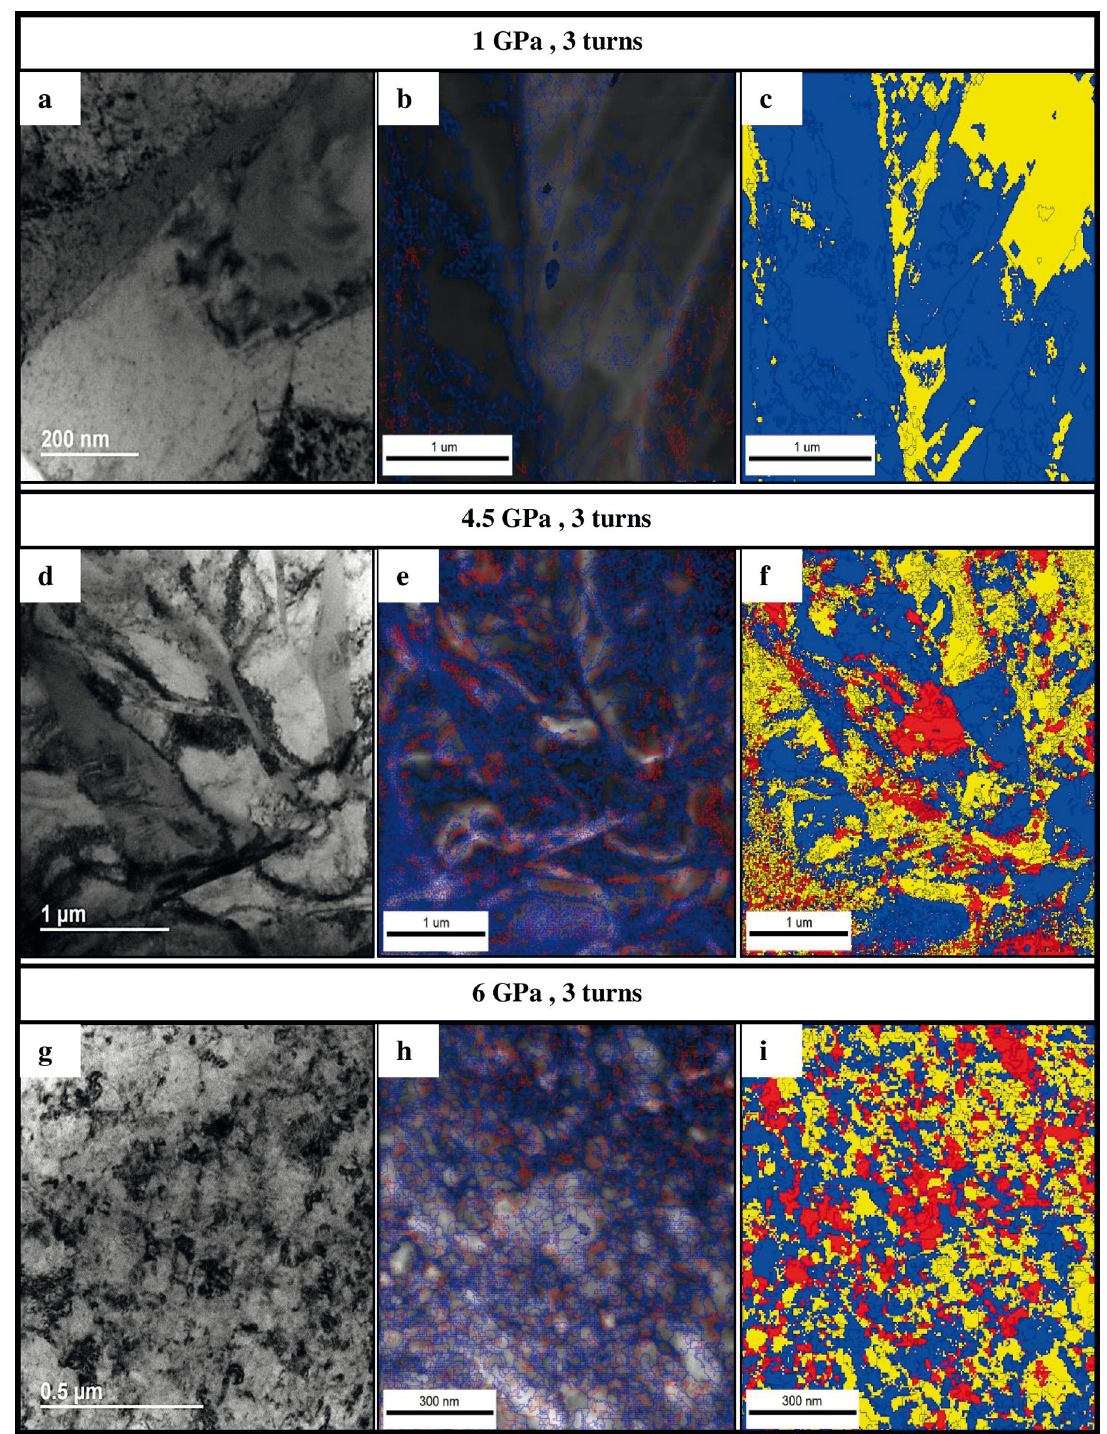
Figure 3. TEM examination after HPT processing; (a) , (d) and (g) Virtual bright field; (b) , (e) and (h) The grain boundary distribution maps; (c) , (f) and (i) Phase map.